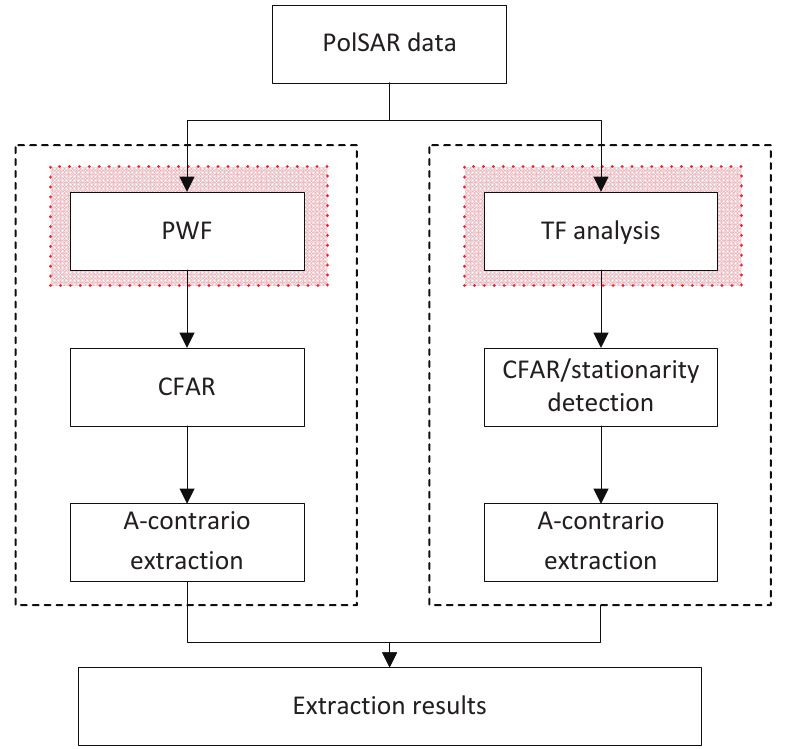
Figure 6. The flowchart of PTT series extraction.